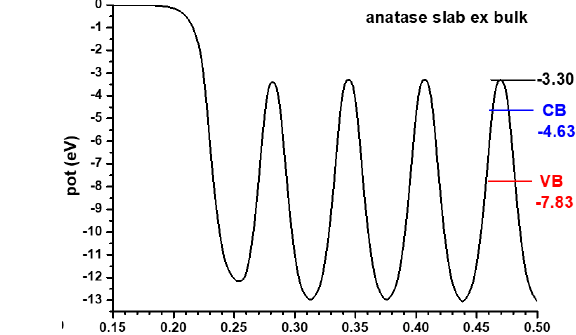
Figure 2. The Hartree potential profile for slabs, facing the vacuum, of ZnO (11 cation planes) and anatase (9 cation planes), indicating for this model the positions in each case of the VB and CB as transferred from the results of Figure 1. These Hartree potential profiles are displayed for only one half of the unit cells.